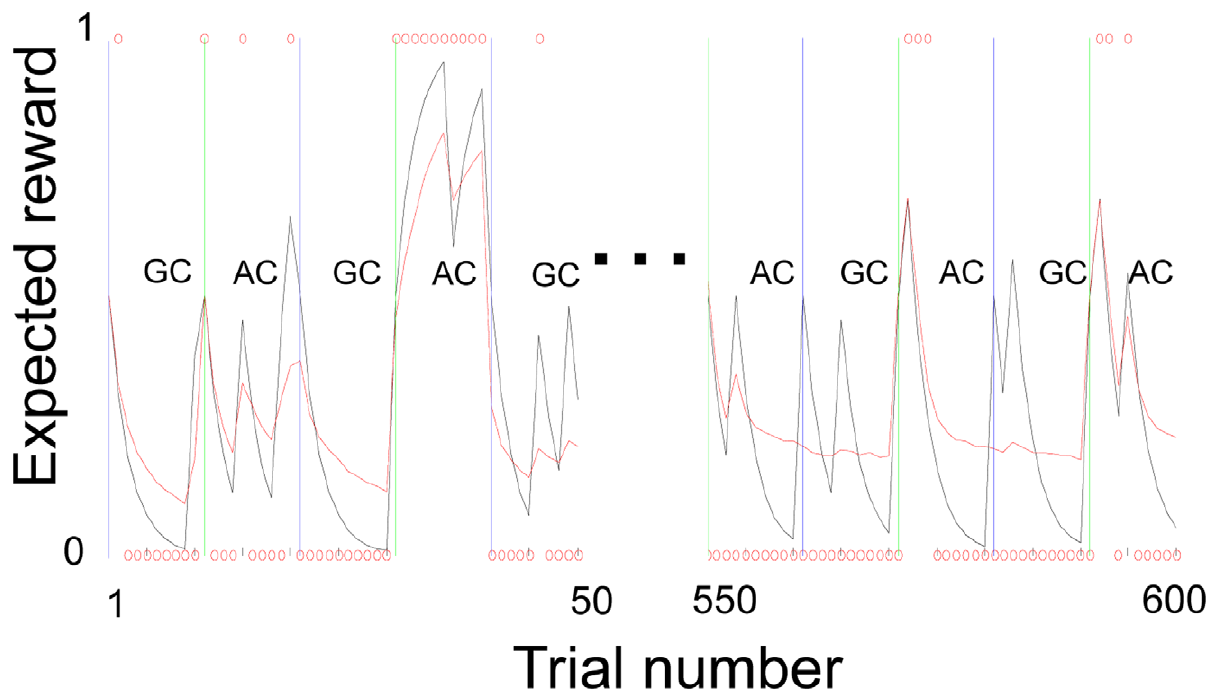
Figure 2. Subject’s predicted value (expected reward) for guessing ‘purple’, according to model-based (M1, red-dashed) and model-free (M2, black) schemes. M1 tracks current information when necessary (AC), and otherwise exploits generalization to limit the impact of spurious outcomes on action (GC). M2 is ignorant about each new individual and myopically chases reward. Red circles indicate the actual guesses of a typical